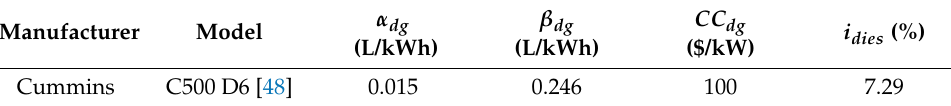
Table 6. Diesel generator